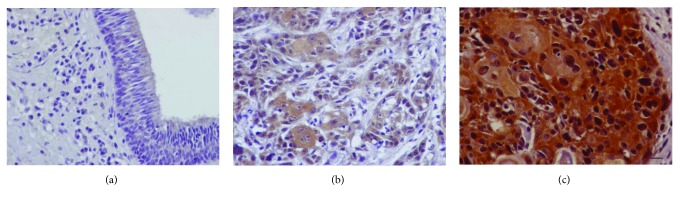
PINCH1 immunohistochemical expression in human laryngeal carcinoma. (a) Negative expression in the adjacent nonneoplastic epithelium. (b) A case of laryngeal carcinoma with low PINCH1 expression. (c) Representative case of laryngeal carcinoma with high PINCH1 expression (cytoplasmic and nuclear). Bar correspond to 50 μm (×400).